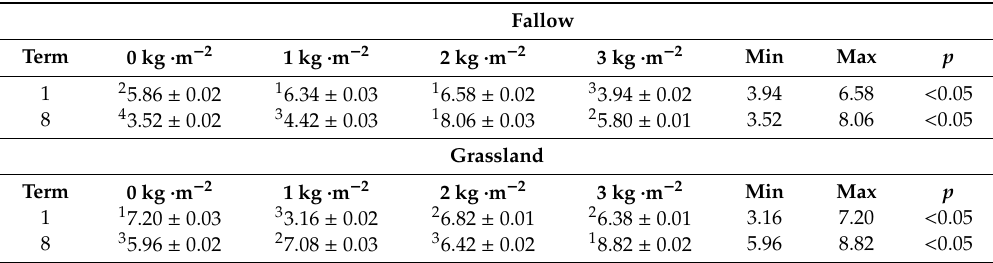
Table 2. Values of the surface negative charge (Q, cmol · kg − 1 ) in soil samples collected from fallow and grassland amended with BioC (0, 1, 2, 3 kg · m − 2 ) for first and eighth term. Average values from three replicates in each term. Other numbers designations (1, 2, 3) indicate significant di ff erences (between values at p < 0.05) among treatments for the same sampling